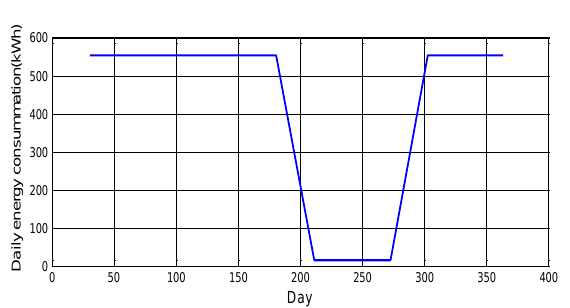
Figure 2. Annual variation of maximal daily energy consumption of Ngoundiane Site